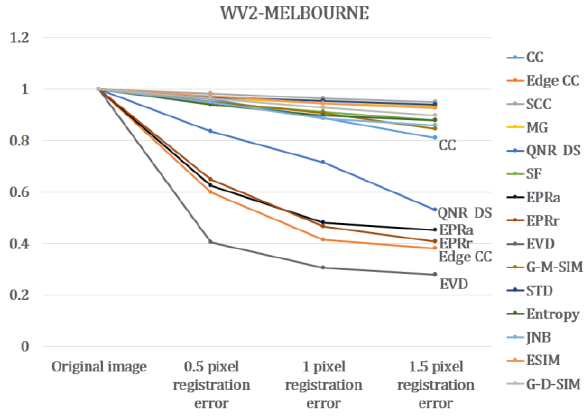
Figure 10. Comparative charts of metrics on data 2.